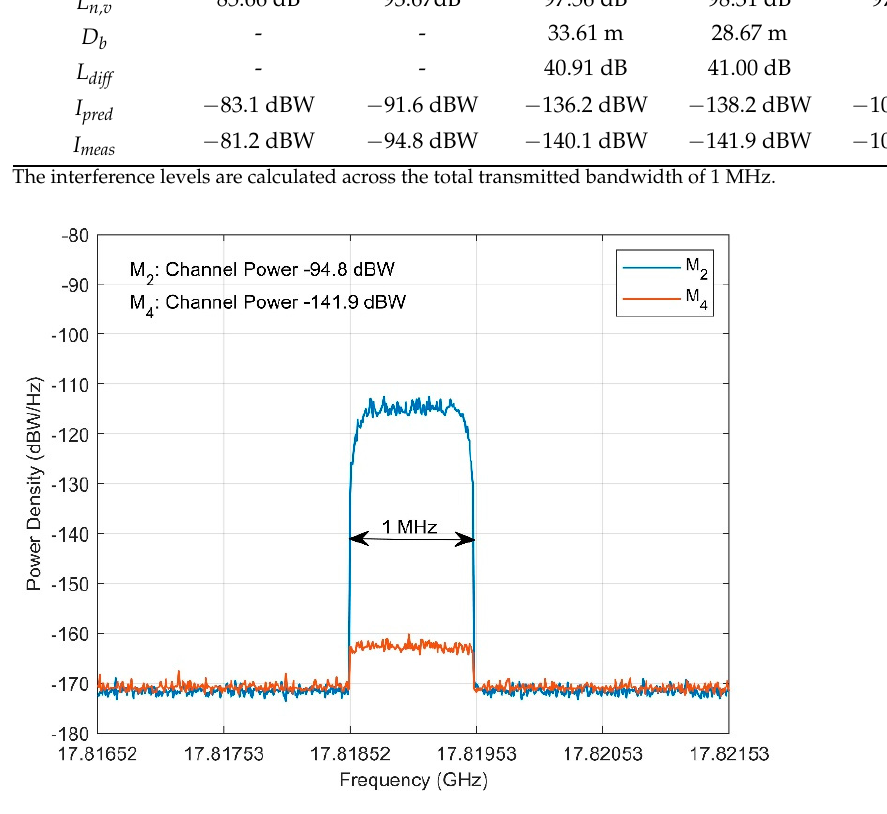
Figure 10. Measured power density for locations M 2 and M 4 . The total channel power expressed across the 1-MHz transmitted bandwidth is also indicated.